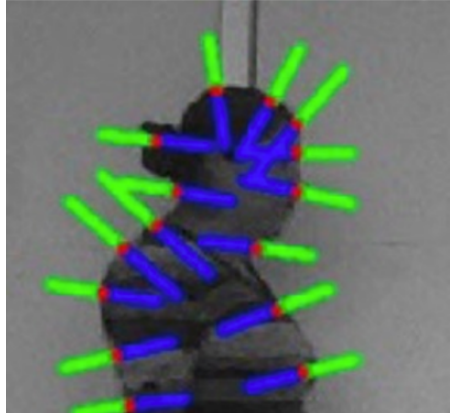
Figure 7. Representation of the misaligned shapes of the training